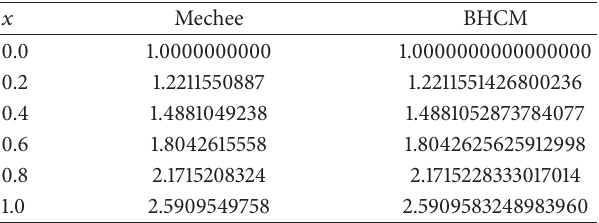
Table 7: Numerical results for problem in Thin Film Flow (29) with ℎ = 0.1, 𝑘 = 3